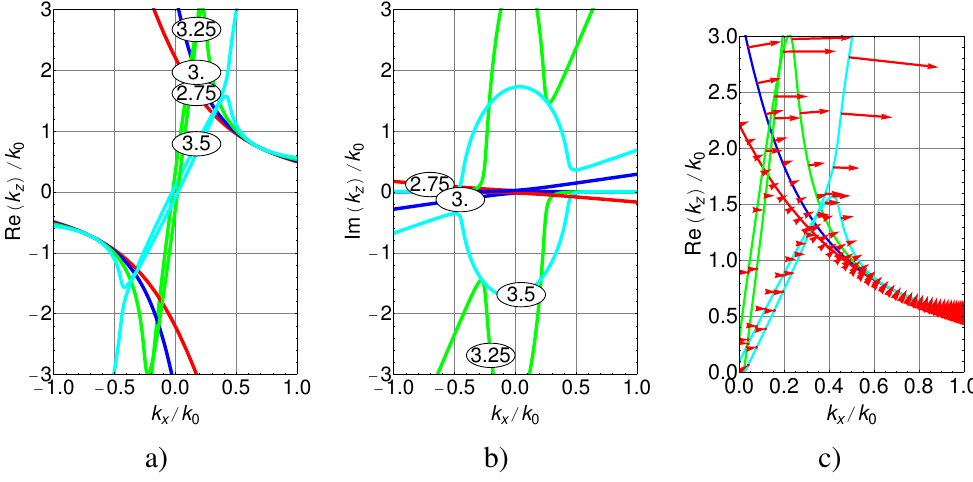
Figure 4. Isofrequencies of the graphene multilayer medium (real part of k part of k ( b )), calculated for frequencies 2.75 (red), 3 (blue), 3.25 (green), and 3.5 (cyan) z and φ = 44 ◦